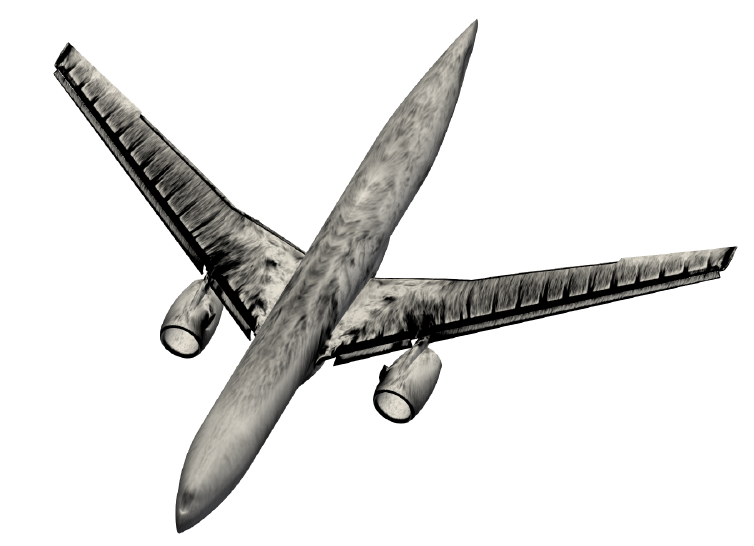
Figure 3. Prediction of the wall shear stress in the High-Lift Common Research Model at an angle of attack of 21 degrees computed using wall-modeled large-eddy simulation with the Alya solver on a grid with 40 million control